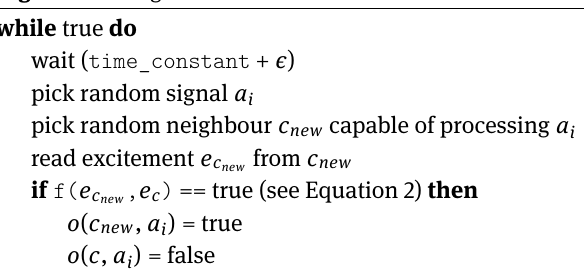
Algorithm 1 Algorithm for cell